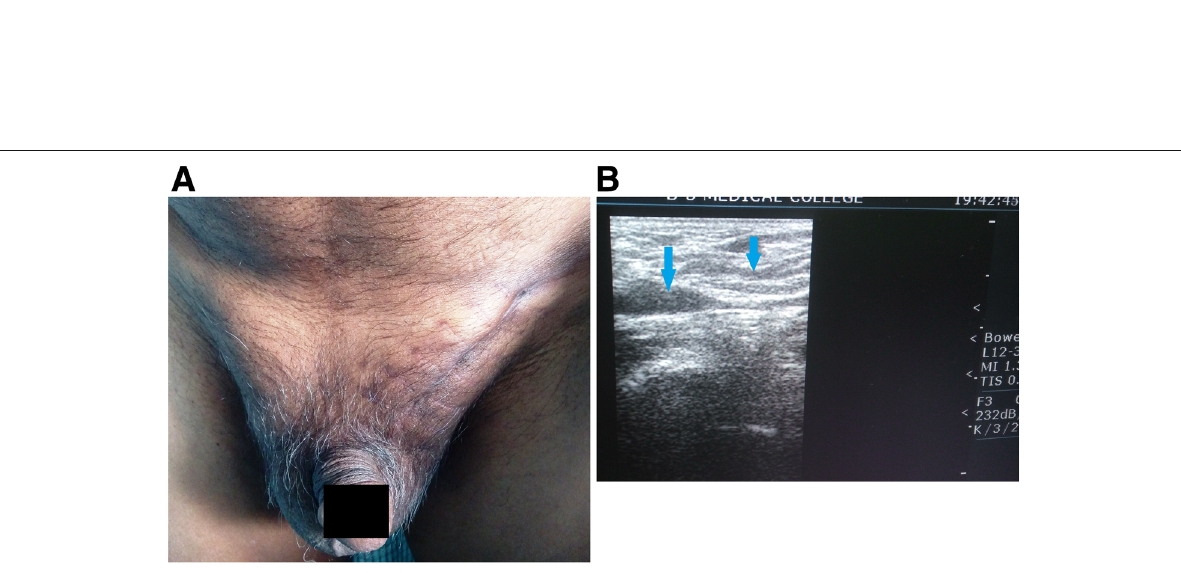
Fig. 4 a Photograph of inguino-scrotal region on follow-up at 4 months. b USG of left spermatic cord shows no thrombus, and full compressibility was noted on 4 months follow-up